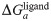
Distinction between the free energy of ligand binding ΔGaligand and free energy of structural relaxation of the receptor-ligand complex with the ligand bound ΔGAPO→ligandligand.(a) The free energy of ligand binding ΔGaligand is the free energy change associated with the process ligand + receptor (apo) ⇌ ligand–receptor (relaxed) complex, wherein a LSD or lisuride ligand binds to a 5-HT2B-TM receptor in the apo conformation and then the ligand–receptor complex relaxes to the stable ligand-bound state. The ligand binding process can be split into two successive steps ligand + receptor (apo) ⇌ ligand–receptor (apo) complex ⇌ ligand–receptor (relaxed) complex. (b) The free energy of structural relaxation ΔGAPO→ligandligand corresponds to the free energy change of the second step, wherein the ligand–receptor complex with the 5-HT2B-TM receptor in the apo-like conformation relaxes to its thermodynamically stable ligand-bound state. The terminal state and thermodynamic driving force for this relaxation differ for LSD and lisuride ligands.